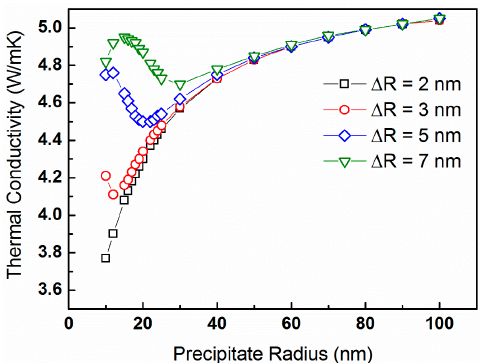
Figure 5. The lattice thermal conductivity of PbTe calculated from expression (16) for constant temperature of T = 300 K and precipitate volume fraction of v f = 5% as a function of the average precipitate radius. The calculations are for precipitate size distributions of ∆ R = 2, 3, 5, and 7 nm, denoted by black squares, red circles, blue diamonds, and green down-triangles, respectively.